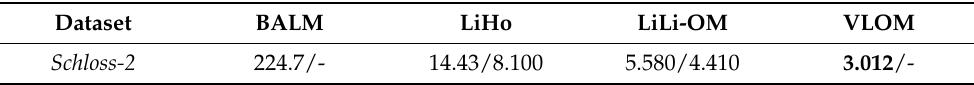
Table 2. End-to-end position error (in meters) on Schloss-2 . We also show the results of the IMU- aided LiHo and LiLi-OM (denoted by the second entry after “/”). The bold indicates the best result. Our method outperforms the IMU-aided LiHo and LiLi-OM (without loop closure), which is an exciting